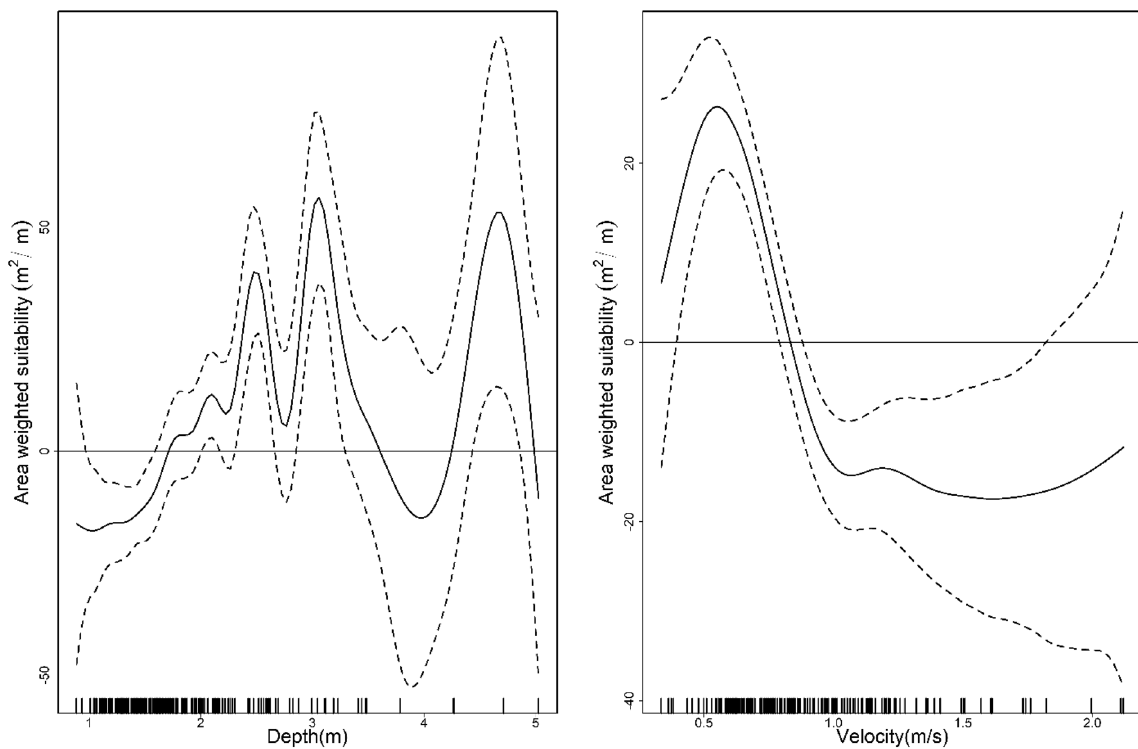
Figure 8. Effects of the depth and velocity on the area weighted suitability (AWS), where several peaks indicate positive and negative (or non-linear relationships) GRD